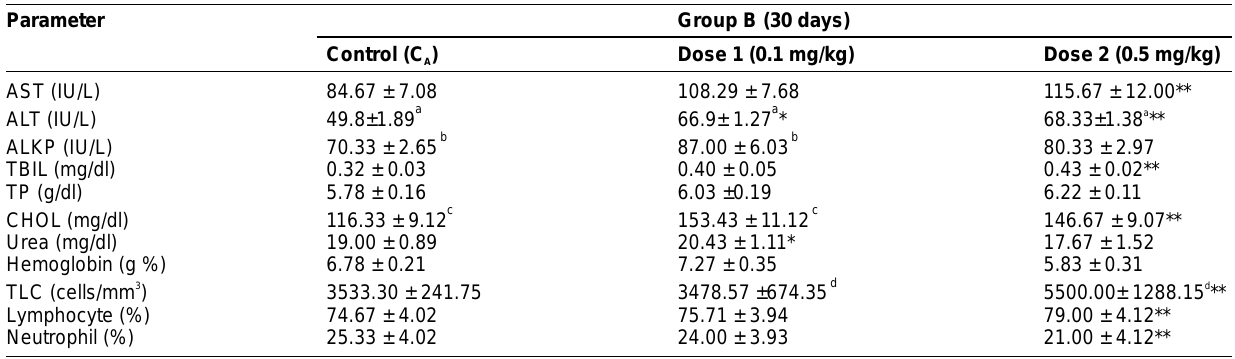
Table-2. Changes in the blood profiles of control and deltamethrin-exposed Swiss albino mice group with 30 days exposure (n = 19).